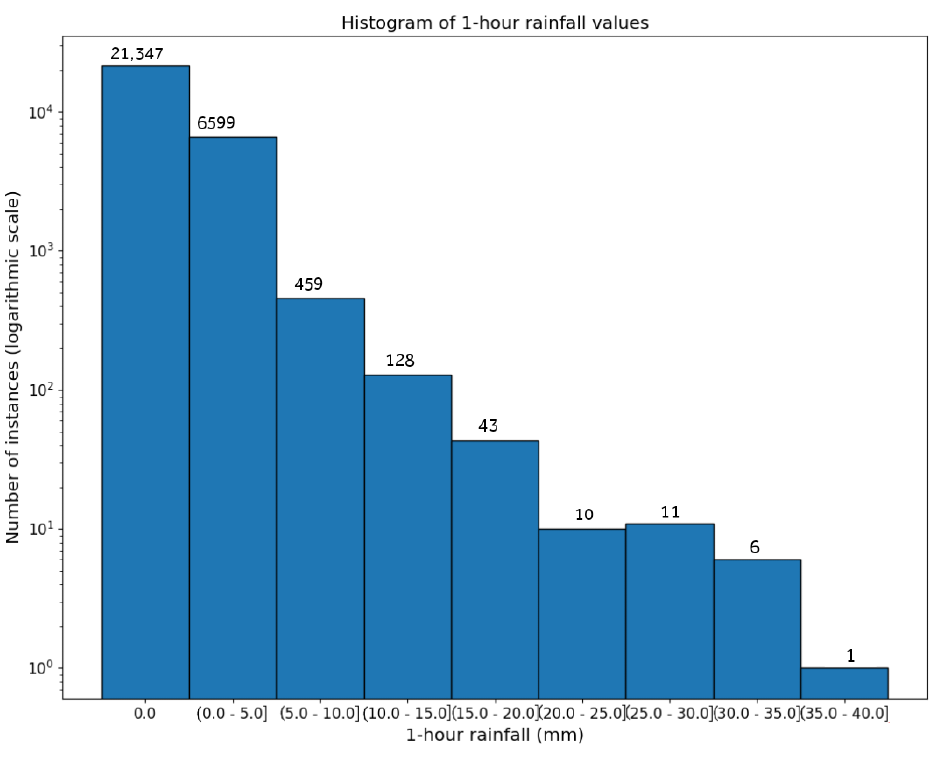
Figure 3. Histogram of the 1-h rainfall values from the data set D